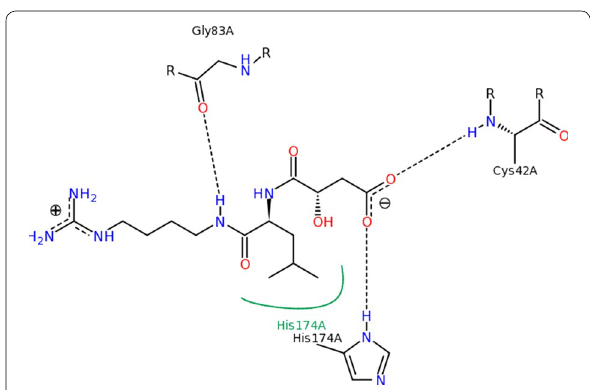
Fig. 7 The interaction of ligand E64 into the binding sites of FP- 2 ( PDB ID: 3BPF